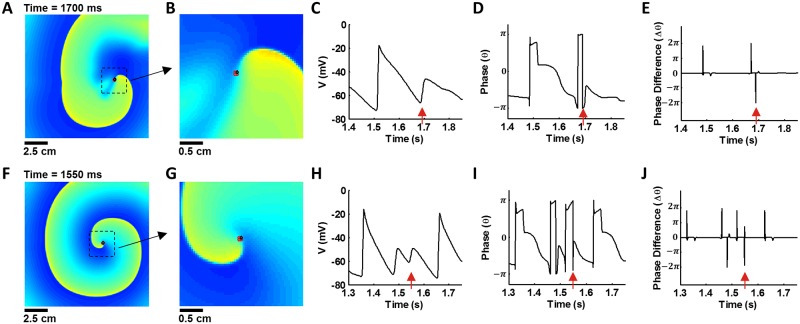
PS detection using the two methods.PS points calculated using the Iyer-Gray method (red circles) and the location-centric method (black diamonds). Snapshots of model dynamics, showing an unstable (control, panels A–E) and a stable (0.3 × ICaL, panels F–J) spiral wave. The PS points calculated by the two methods overlapped in the 2D map. B, G: zoomed images. C, H: Action potentials at PS points. D, I: Phases. E, J: Phase differences.